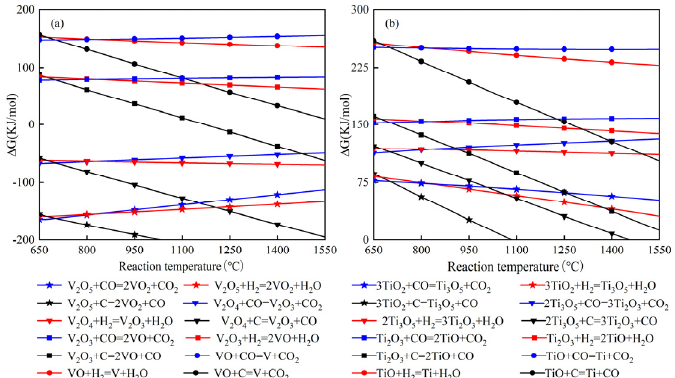
Figure 1. Gibbs free energy of standard reaction for reduction of vanadium oxide and titanium oxide: ( a ) vanadium oxide; ( b ) titanium oxide.